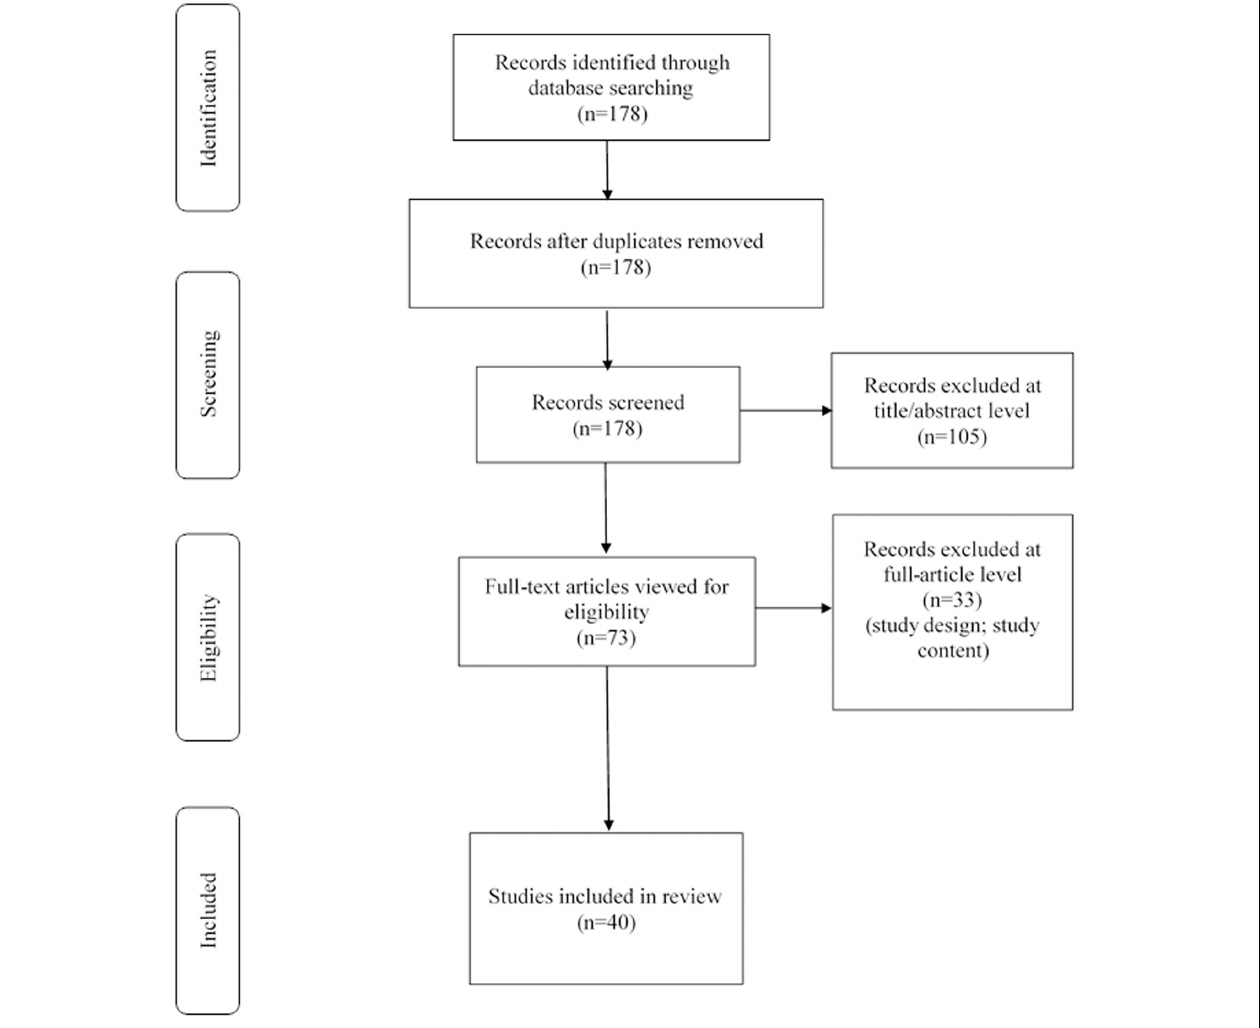
FIGURE 1 | Search strategy: A methodological evaluation of each study was examined according to the PRISMA standards, including an assessment of